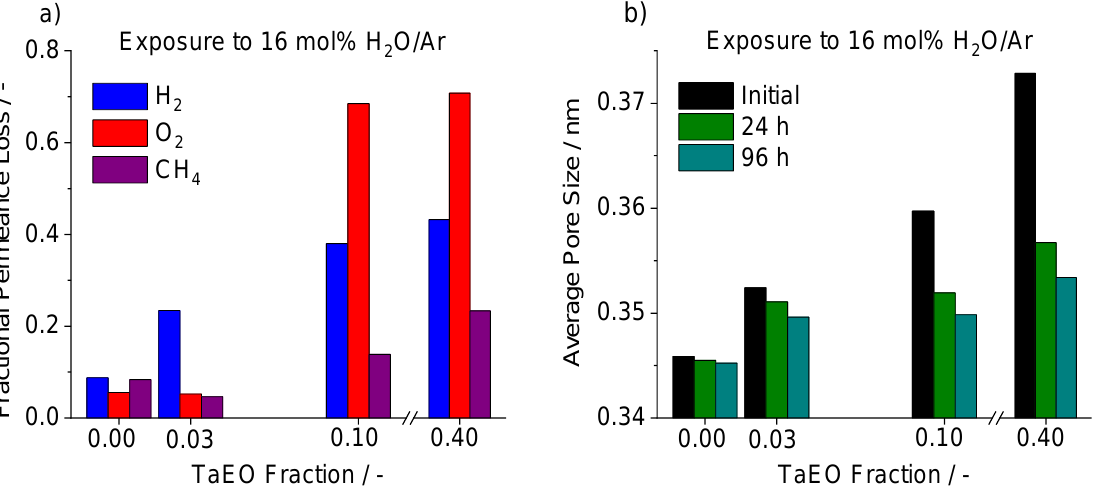
Figure 9. ( a ) Fractional permeance loss at 650 °C of H 2 , O 2 and CH 4 for the various Si – Ta membranes after exposure to a 16 mol% H 2 O in Ar gas atmosphere for 96 h. ( b ) Change in calculated pore size of the Si – Ta membranes from exposure to a 16 mol% H 2 O in Ar stream after 24 h and 96 h. Figure 9b shows that the average pore size tends to increase with TaEO fraction.